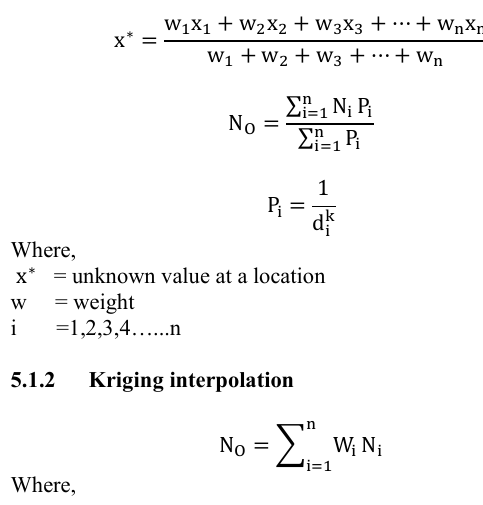
different seasons. The different color pattern use in mapping